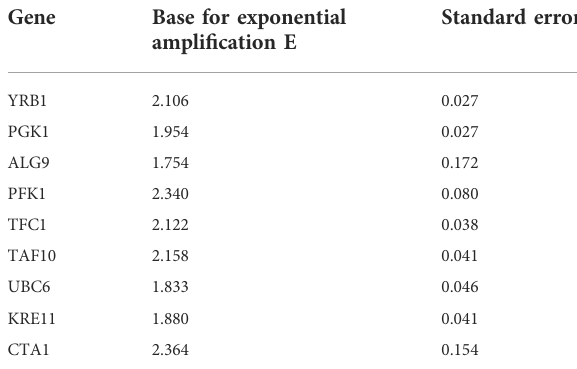
TABLE 3 Ampli fi cation ef fi ciencies and standard errors of designed primers.